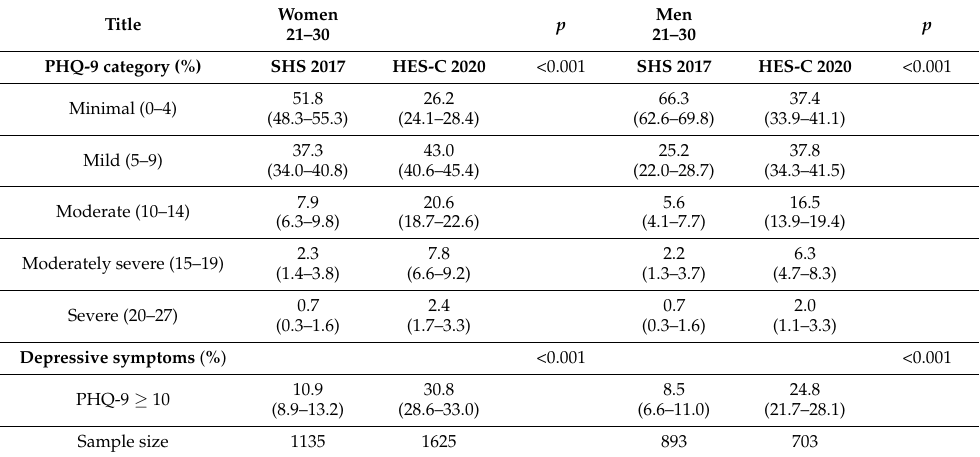
Table 2. Adjusted prevalence of depressive symptoms in the Swiss Health Survey 1 (SHS) and the Health in Students study during the Corona pandemic (HES-C).